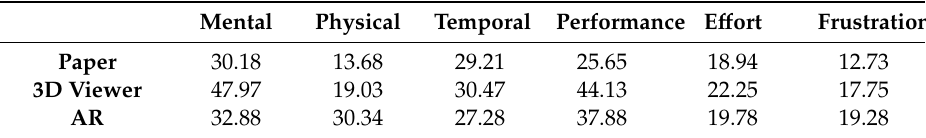
Figure 14. Average NASA-TLX scores of the three forms.